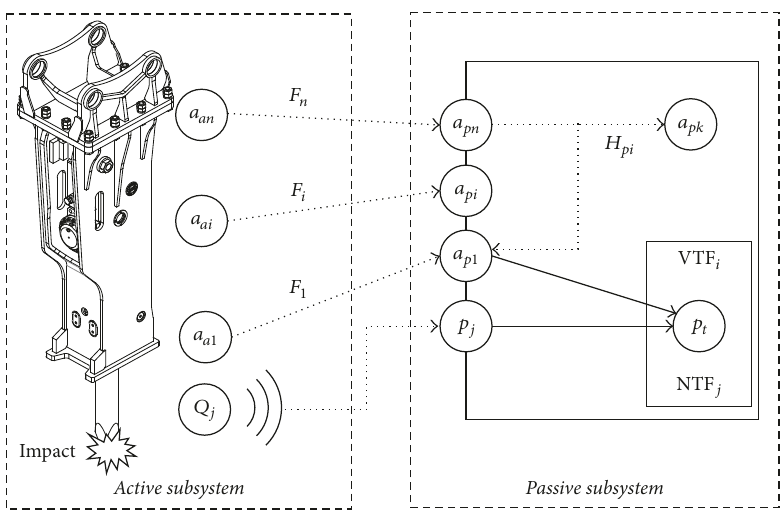
Figure 4: Schematic of transfer path analysis model; active subsystem generating force and acoustic loads and a passive subsystem responding to these loads (modified from Gajdatsy et al.